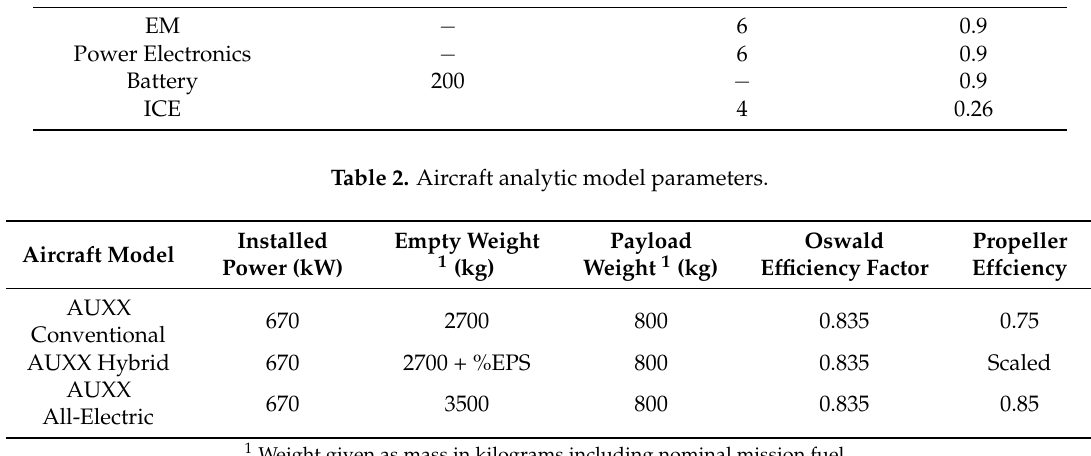
Table 1. Power system analytic model parameters.